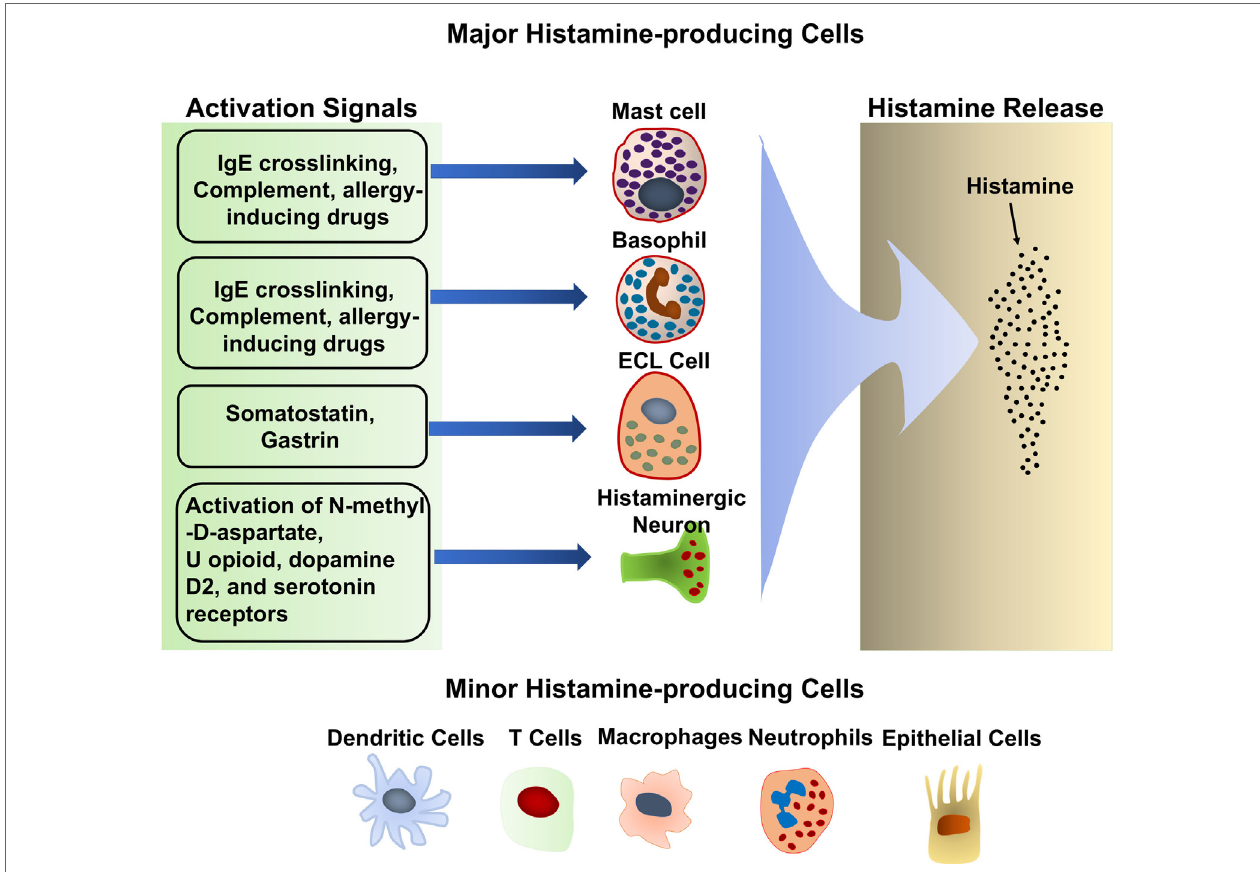
FigURe 2 | Histamine-producing cells and stimuli that trigger histamine